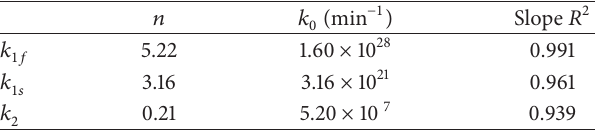
Table 2: Estimated 𝑛 and 𝑘 0 for 𝑘 1𝑓 ,𝑘 1𝑠 , and 𝑘 2